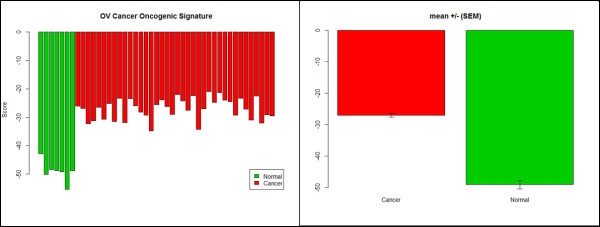
Ovarian cancer gene signature. Gene signature constructed from the expression values for each of genes given in Table 2, by substracting the sum of the down-regulated gene expression values from the sum of the up-regulated gene expression values. A. Individual scores for each of the normal and cancer patients. B. Mean signature values +/- (SEM) for the normal and cancer patients. Welch two sample t-test (t = -14.69, df = 8.45, p=2.621E-07).